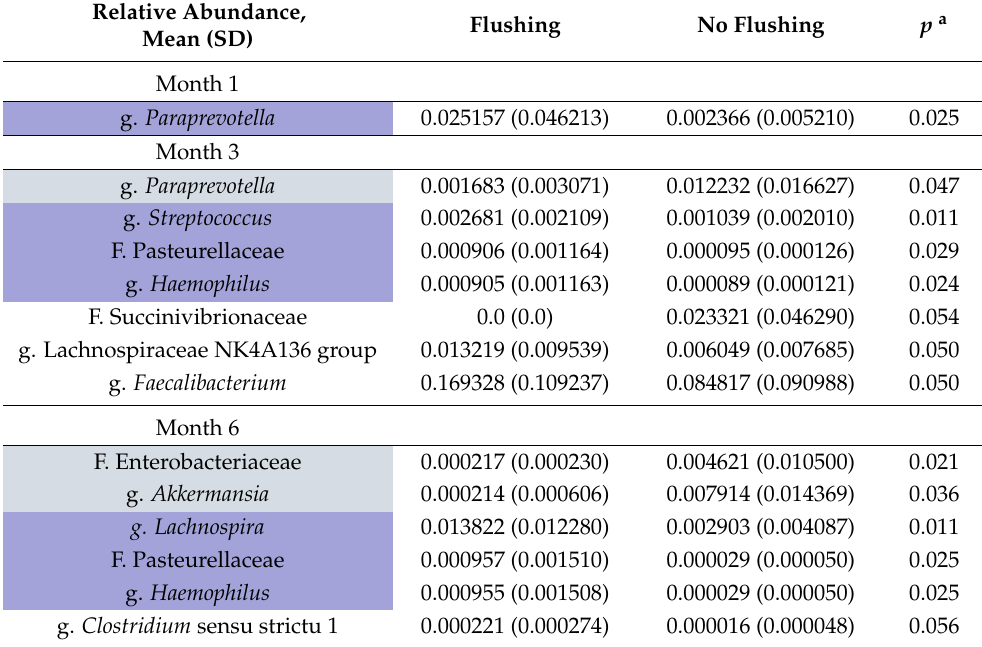
Table 5. Microbiota composition (expressed as relative abundance and SD) by flushing occurrence during the follow-up. The microorganisms in light gray are lower in subjects with flushing, and those in purple are